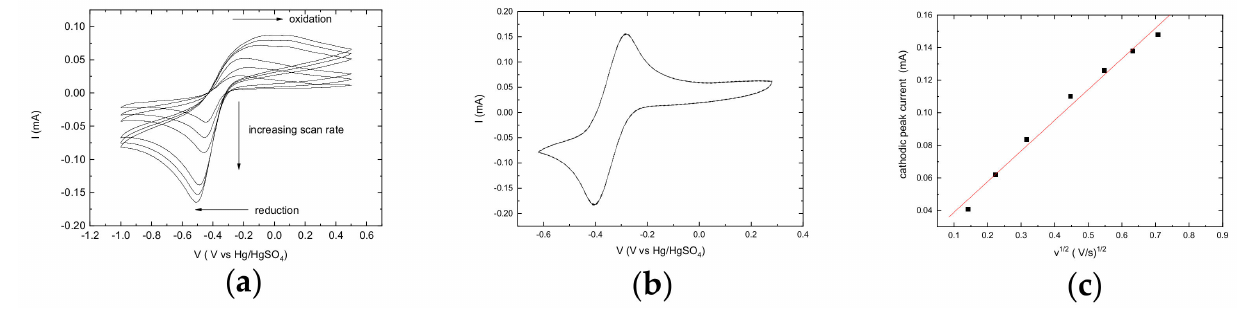
Figure 5. ( a ) CV of 1.675 × 10 − 3 M Co(II)/(III) at Au nanoparticles electrode (by chemical reduction) in ACN/0.1 M LiClO 4 . ( b ) CV of Co(II)/(III) ~2 × 10 − 3 M at an Au film (by thermal evaporation)